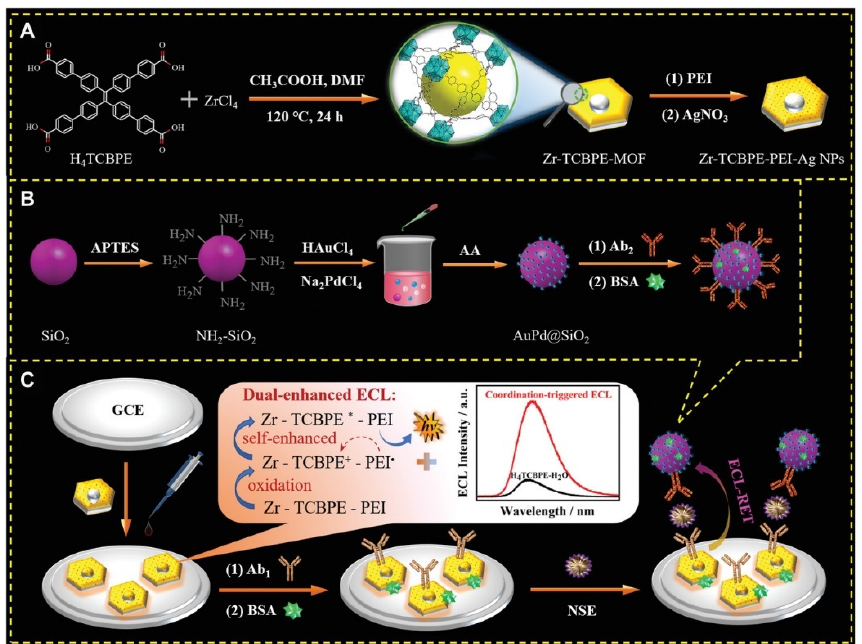
Figure 5. Schematic illustration for the synthesis of ( A ) Zr-TCBPE-PEI-Ag NPs substrate and ( B ) Ab 2 -AuPd@SiO 2 bioconjugate, and ( C ) the fabrication process of the proposed ECL immunosensor with possible ECL-enhancing effects and luminescence mechanism [64]. Copyright © 2022, John Wiley and Sons.